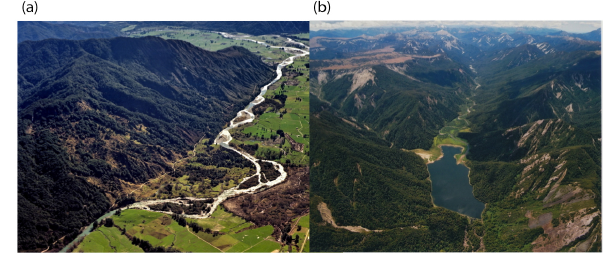
Figure 5. (a) Matakitaki landslide triggered by the 1929 earth- quake. Debris from this large (18 million m 3 ) dip-slope rockslide travelled ∼ 1km across the valley floor, killing four people and forming a landslide dam. Note that, after over 70 years, the land- slide scar is still visible. (b) Aerial view of the Matiri Valley (15km north of Murchison), which was extensively damaged by landslides during the 1929 earthquake. Numerous scars of rockfall and debris slides are still clearly visible in 2011.